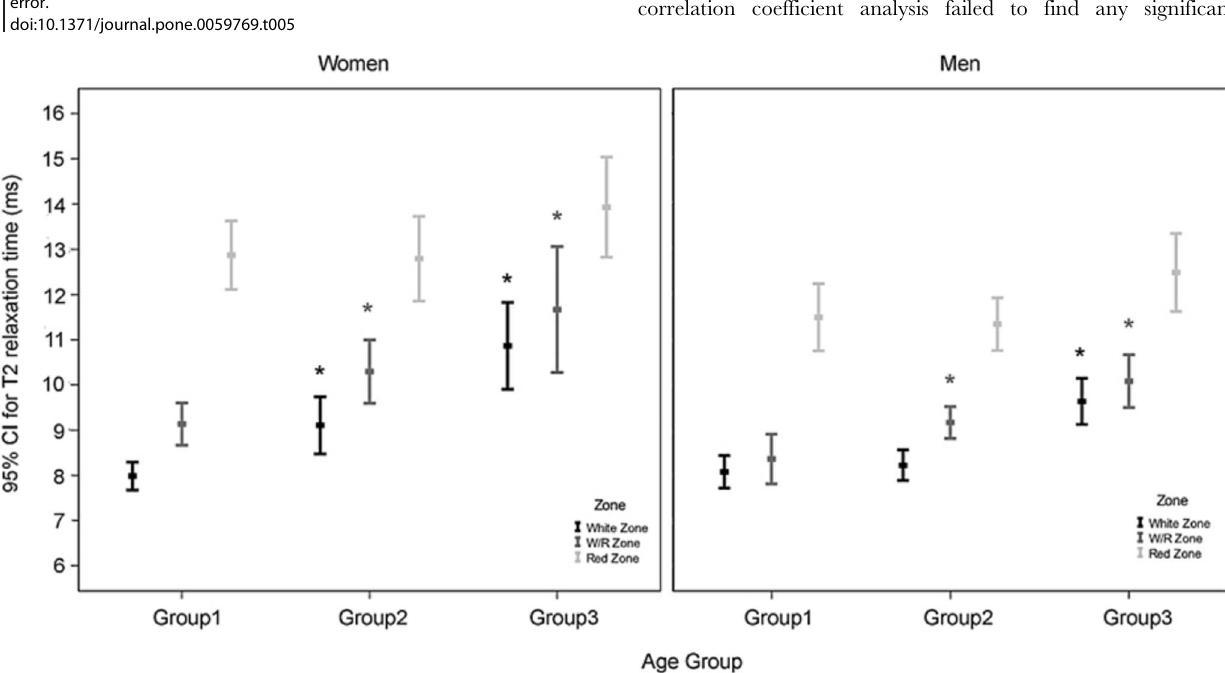
Figure 5. T2 values of the three zones in three age groups of women and men. The differences in T2 values for the white zone and R/W zone in women and men are significantly greater between group 3 and group 1 and between group 2 and group 1 (* P , 0.01) but no corresponding differences exist for the red zone in women and men.